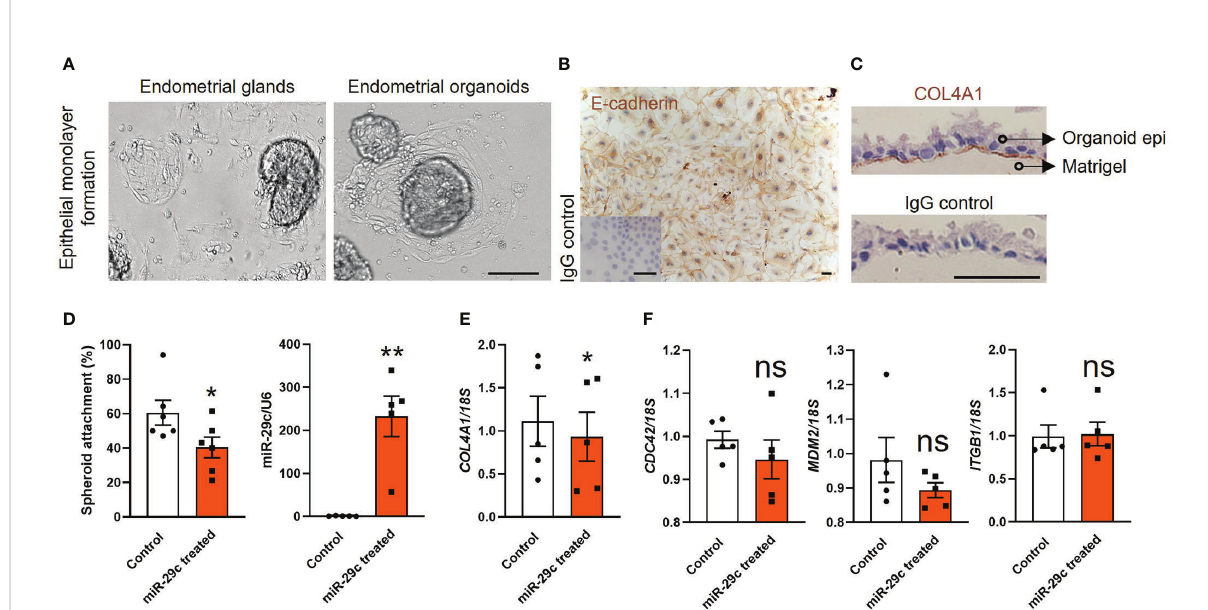
FIGURE 3 Fertile endometrial organoid sourced epithelial cells and HEECs respond similarly to miR-29c overexpression. (A) Endometrial epithelial cells outgrew similarly from endometrial glands and organoids. The scale bar represents 100 m m. (B, C) Immunocytochemistry staining of organoid derived epithelial monolayer with E-cadherin (epithelial marker) and COL4A1 (basal membrane marker). An IgG control was included in which the non-immune antibody of the same isotype (IgG) was substituted for each primary antibody at the same concertation. The scale bar represents 50 m m. (D) Overexpression of miR-29c in fertile organoid-derived epithelial monolayers signi fi cantly reduced HTR8/SVneo trophoblast spheroid adhesion compared to control. Similar effects on adhesion have been identi fi ed using HEECs 11 . (E, F) After transfection, organoid sourced epithelial monolayers were also subjected to RT-qPCR analysis to determine the expression of potential miR-29c targets as previously examined in HEECs 11 . Consistently, only COL4A1 expression was signi fi cantly decreased after miR-29c overexpression compared to control. miR-29c expression was normalized to U6. Gene expression levels were normalized to 18S . All data were presented as mean ± SEM (n=5-6 biological replicates). * P <0.05, ** P <0.01, ns, no signi fi cant